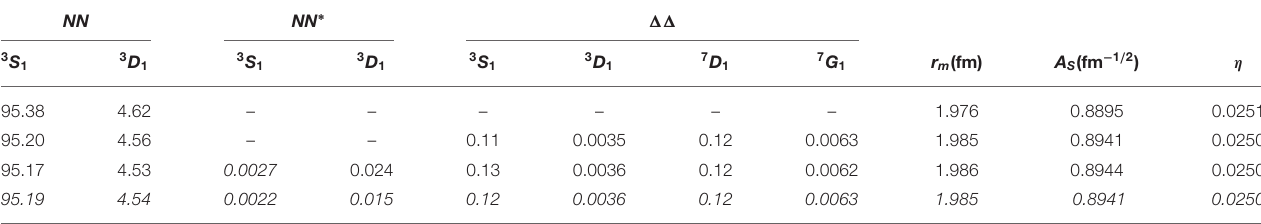
TABLE 4 | Different components in ( % ) of the deuteron wave function. NN NN ∗